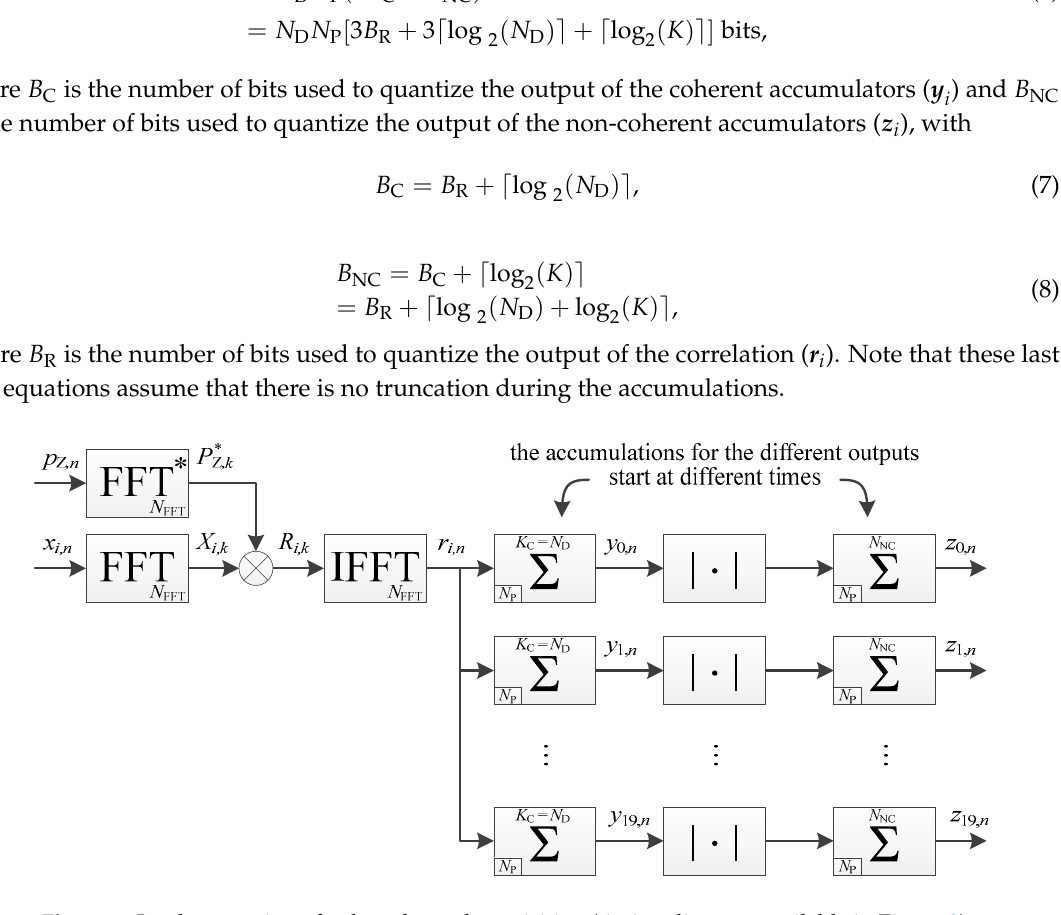
Figure 3. Timing diagram of a data channel acquisition shown in Figure 2, with (cid:1840) (cid:2888) = 4 for the illustration (in reality (cid:1840) (cid:2888) = 20 for the GPS L1 C/A signal). Colors indicate different portions corresponding to the length of one data bit. Grey color indicates intermediate results (i.e., the value is not yet the final one).